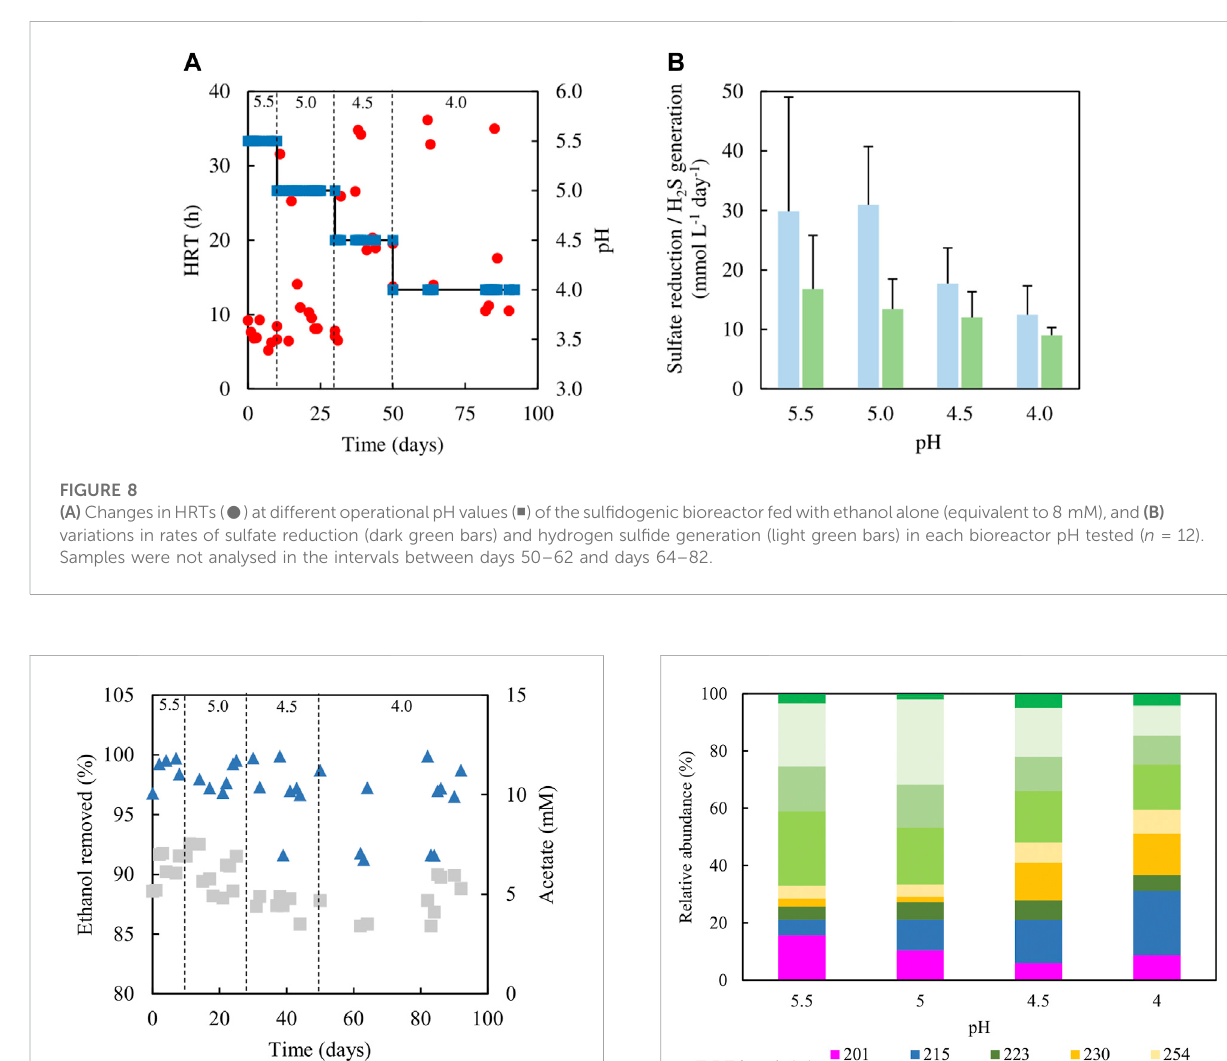
FIGURE 9 Differences in ethanol concentrations in in fl uent and ef fl uent liquors ( ▲ ), and concentrations of acetate/acetic acid in ef fl uent liquors( ■ ),duringtestscarriedoutwiththesul fi dogenicbioreactor using ethanol as the main electron donor. Samples were not analysed in the intervals between days 50 – 62 and days 64 – 82.